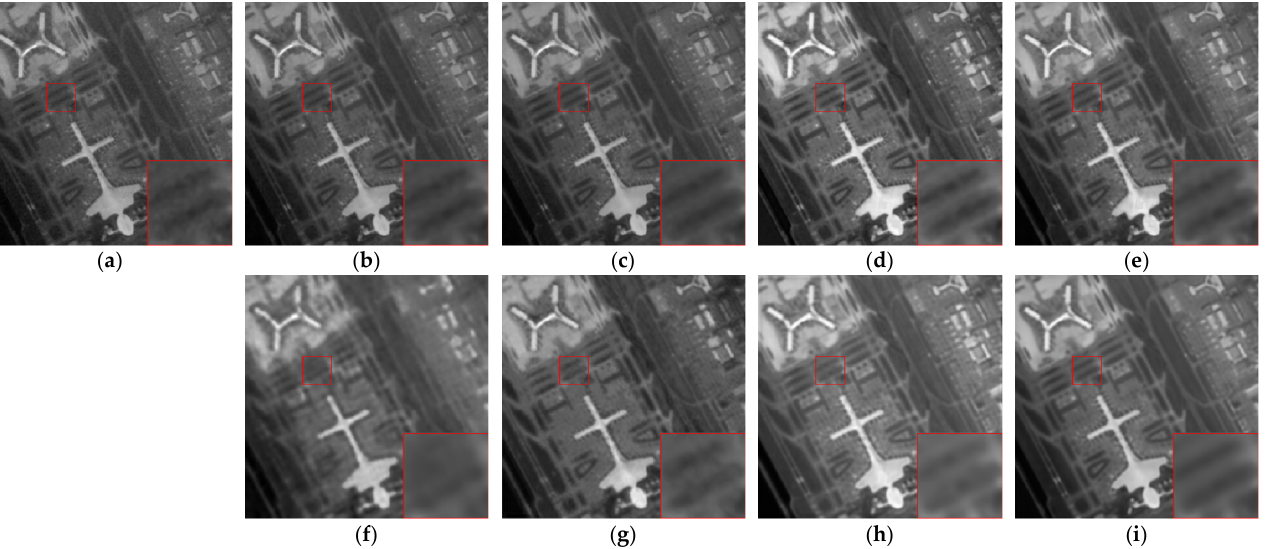
Figure 15. ZH-1 hyperspectral image denoising results with band 1: ( a ) real image; ( b ) BM4D; ( c ) LRMR; ( d ) HyRes; ( e ) L1HyMixDe; ( f ) DHP-2D; ( g ) SIP; ( h ) SURE-CNN; and ( i ) 3S-HSID.